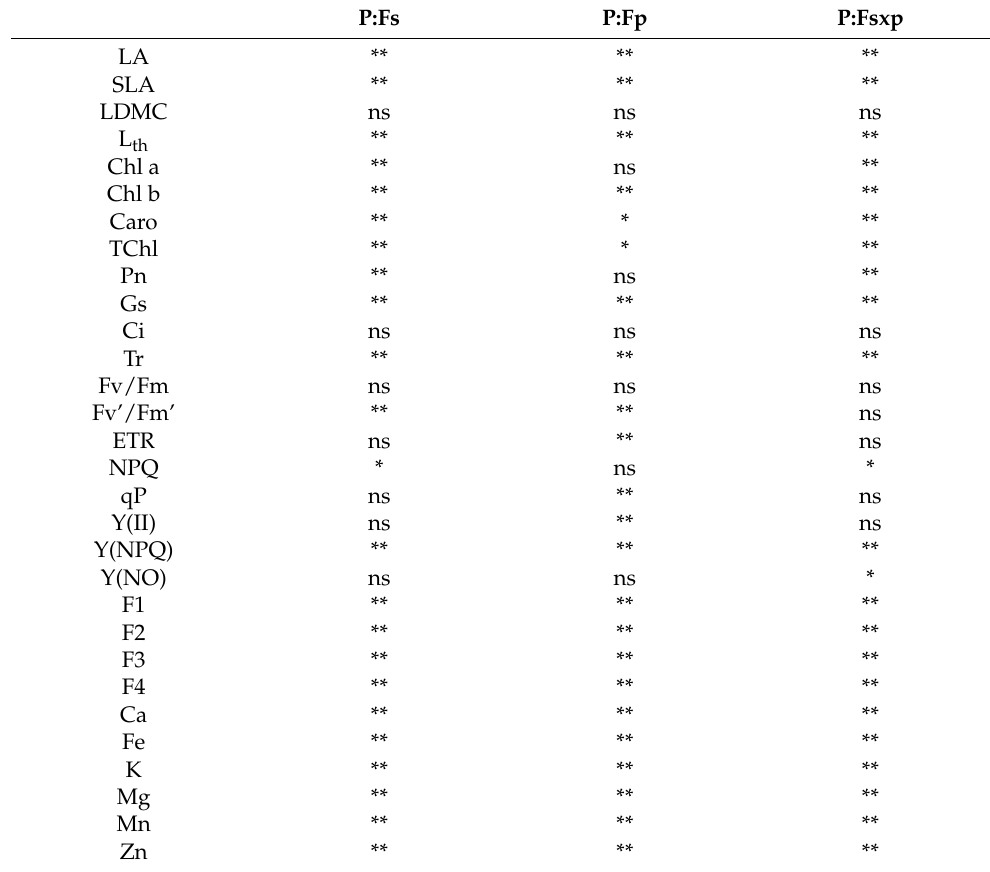
Table A2. The significance test for the effects of sex, Pb treatment, and their interaction on the parameters considered in this study. ns, non-significant; *, p < 0.05; **, p < 0.01; Fs, sex effect; Fp, Pb content effect; Fsxp, interaction effect of sex and Pb content.